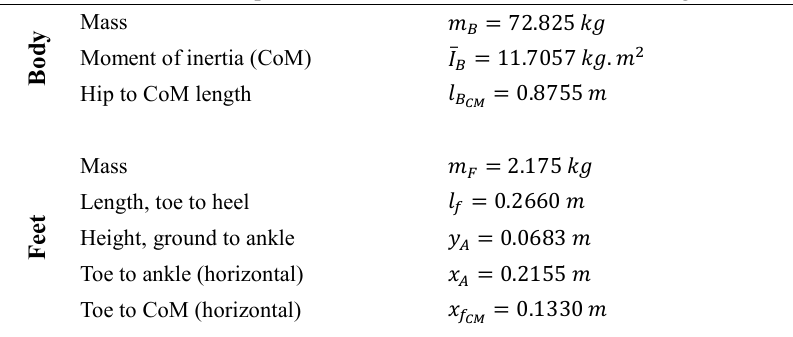
Figure 1. The 2-link dynamical model consisting of two rigid parts: the feet and the rest of body, jointed at the ankle. External and internal forces, and the control input (ankle torque) are shown by red Table 1. Anatomical parameters used for the 2-link model of Figure 1.